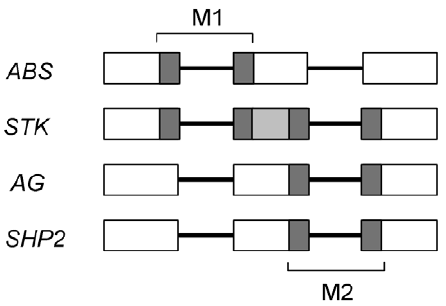
Figure 4. Homologous interaction motifs overlapping with AIPs. Conserved intron positions of the Arabidopsis ABS , STK , AG and SHP2 genes are represented by horizontal lines and their flanking exons by rectangles. Grey colored regions correspond to predicted interaction motifs that overlap with AIPs. The light grey motif only overlaps the AIP in STK . M1 : Homologous interaction motifs that overlap with AIPs in ABS and STK . M2 : Homologous interaction motifs that overlap with AIPs in STK , AG , and SHP-2 .